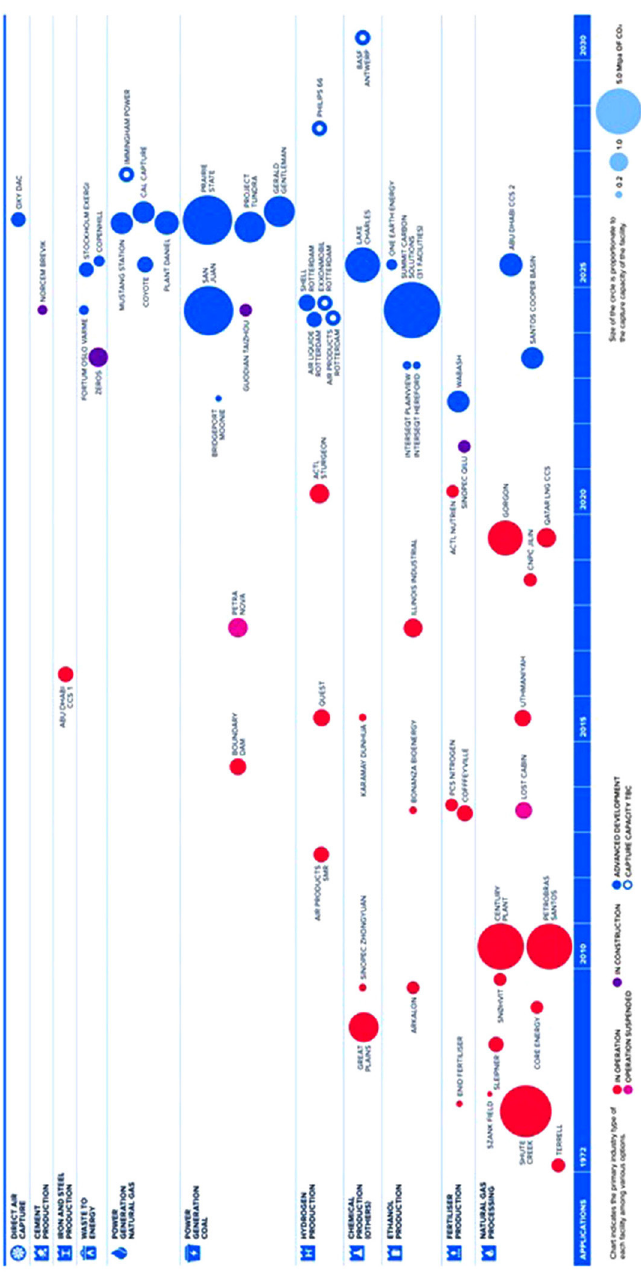
Fig. 6. – CCS projects by sector and scale over time [2].